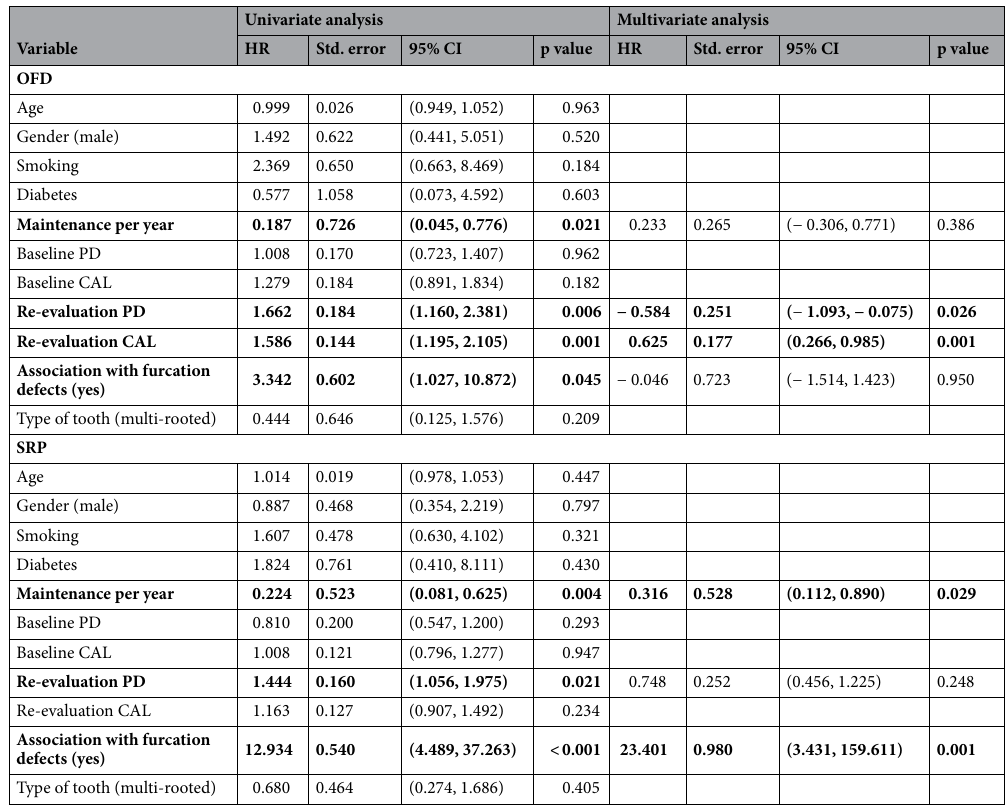
Table 1. Results of the multilevel cox proportional hazard models evaluating the effect of different variables on the survival of the treated teeth. The values in bold signifies statistical significance; CI, confidence intervals. Data related to the presented variables was available for all 132